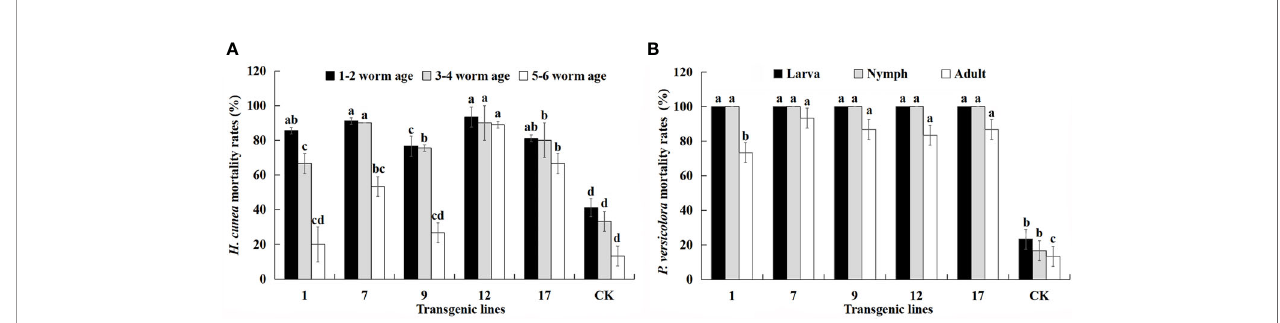
FIGURE 6 | Mortality (%) of all larval ages of H. cunea and stages of P. versicolora feeding on transgenic lines and control plants. Data are mean of the fi nal mortality rate of larvae of each age in three biological replicates of each line. 1, 7, 9, 12, and 17 correspond to fi ve transgenic lines; CK, non-transgenic line. (A) Mortality of all larval ages of H. cunea feeding on transgenic lines and control plants. (B) Mortality of all stages of P. versicolora feeding on transgenic lines and control plants. Bars with different letters indicate signi fi cant differences in larval mortality. Error bars represent the standard deviation of the mean. According to Duncan ’ s multiple range test ( p < 0.05), different letters indicate signi fi cant differences in larval mortality and the same letters indicate no signi fi cant differences between